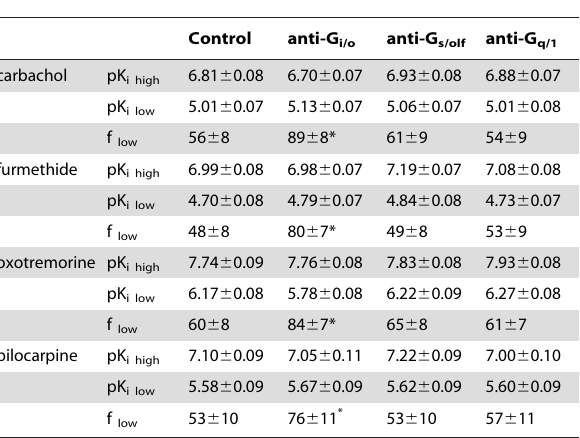
Data are means 6 S.E.M. From 3 experiments performed in quadruplicates. f low , fraction of low-affinity sites in percent; *, significantly different from control by t-test (P , 0.05).